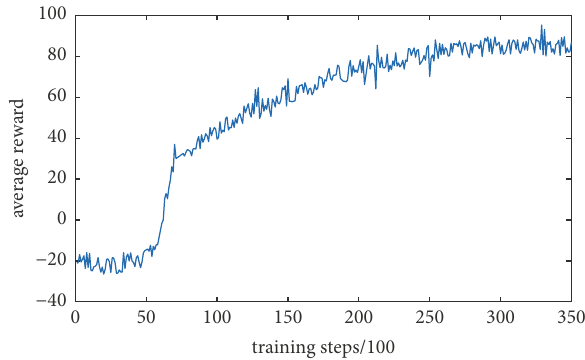
Figure 5: The average cumulative reward curves. Each point is the average cumulative reward achieved per hundred episodes. The 𝑦 -axis denotes the average cumulative reward and x -axis denotes iteration